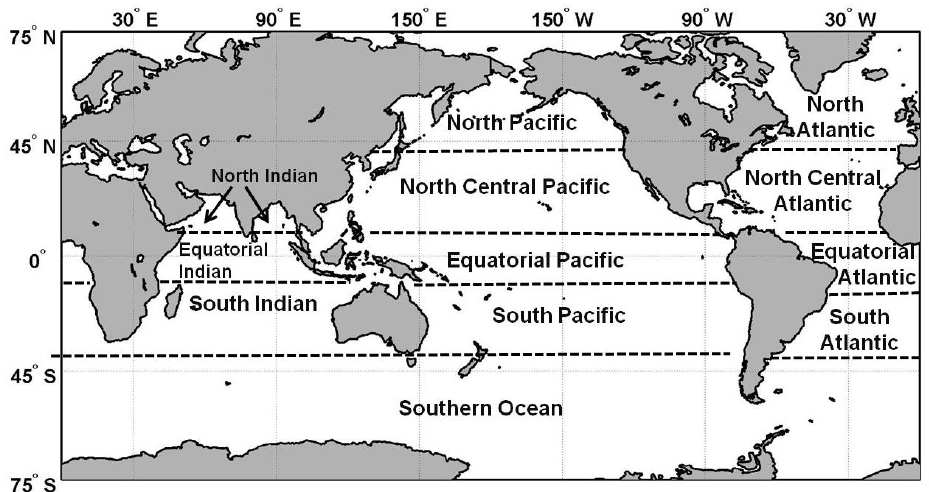
Figure 1. The 12 major oceanographic basins in the